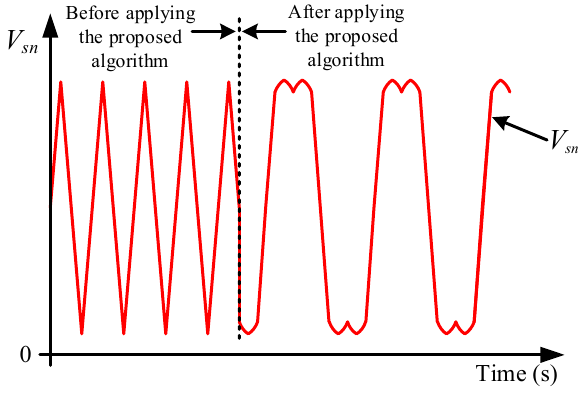
Figure 7. Offset voltage reference V sn before and after using the proposed code for fault tolerance.